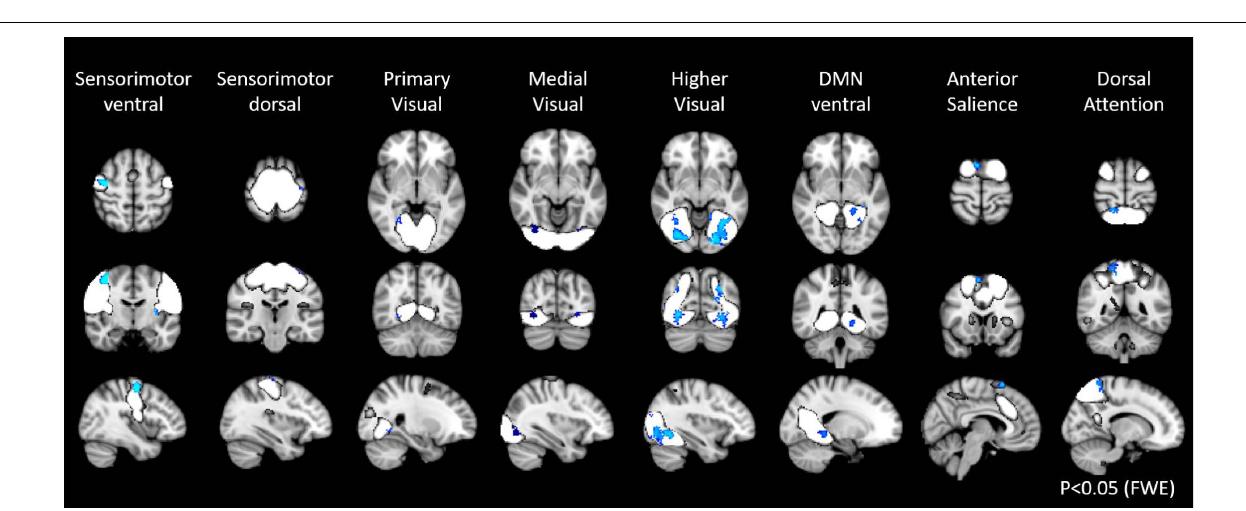
FIGURE 5 | Resting state networks, shown in white, with within-network functional connectivity values that negatively correlated with age. The clusters shown in blue represented the areas with connectivity values showing significant negative correlation with age (FWE p < 0.05).